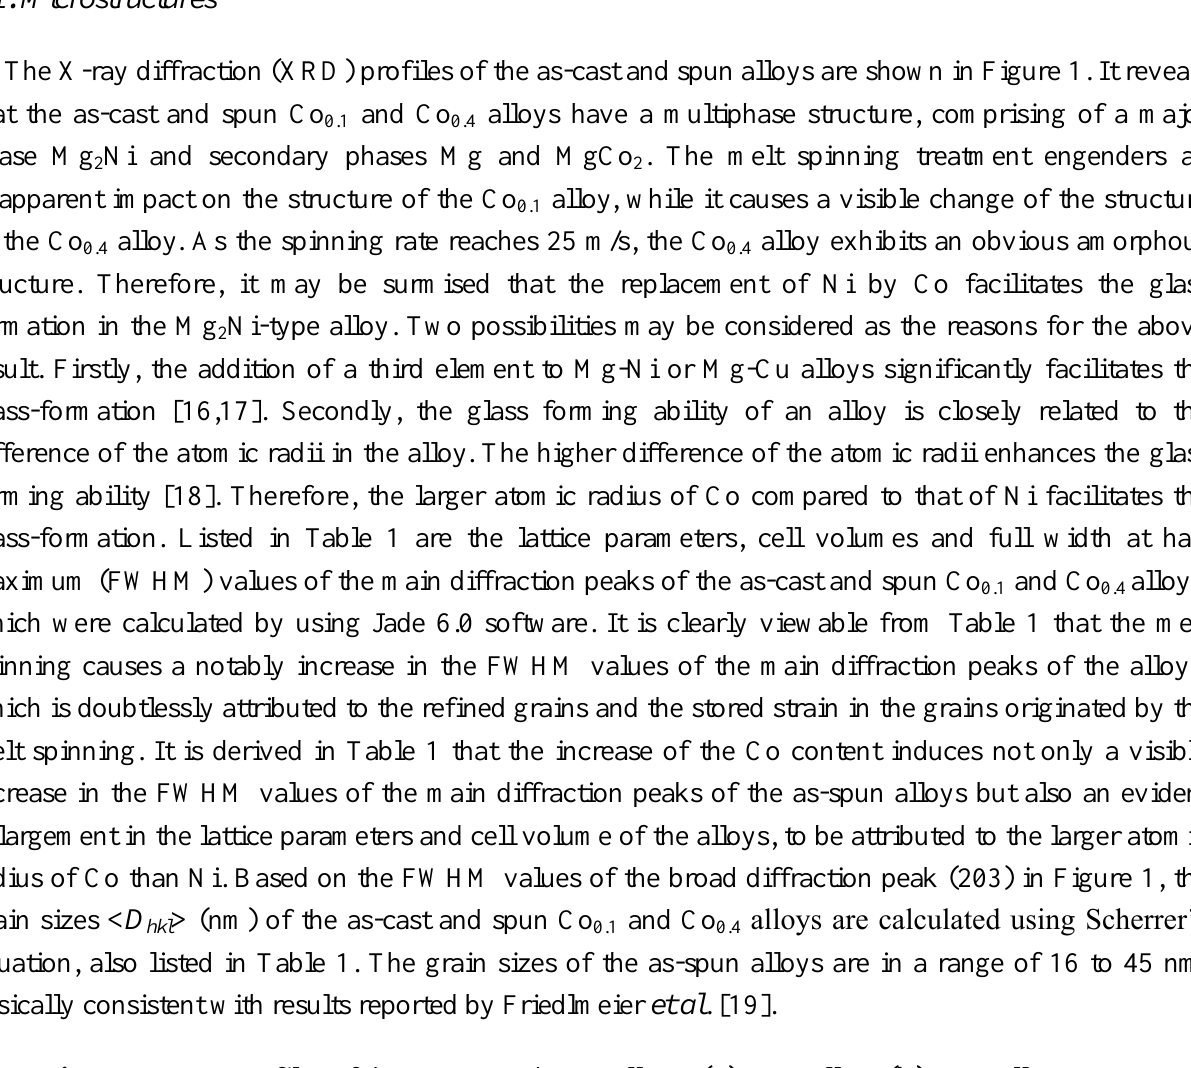
alloy; ( b ) Co 0.1 0.4